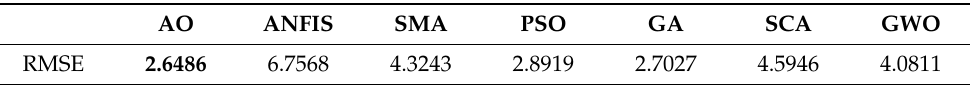
Table 8. The results of the Friedman test for the Almasila oilfield’s dataset. The best value is shown in bold.